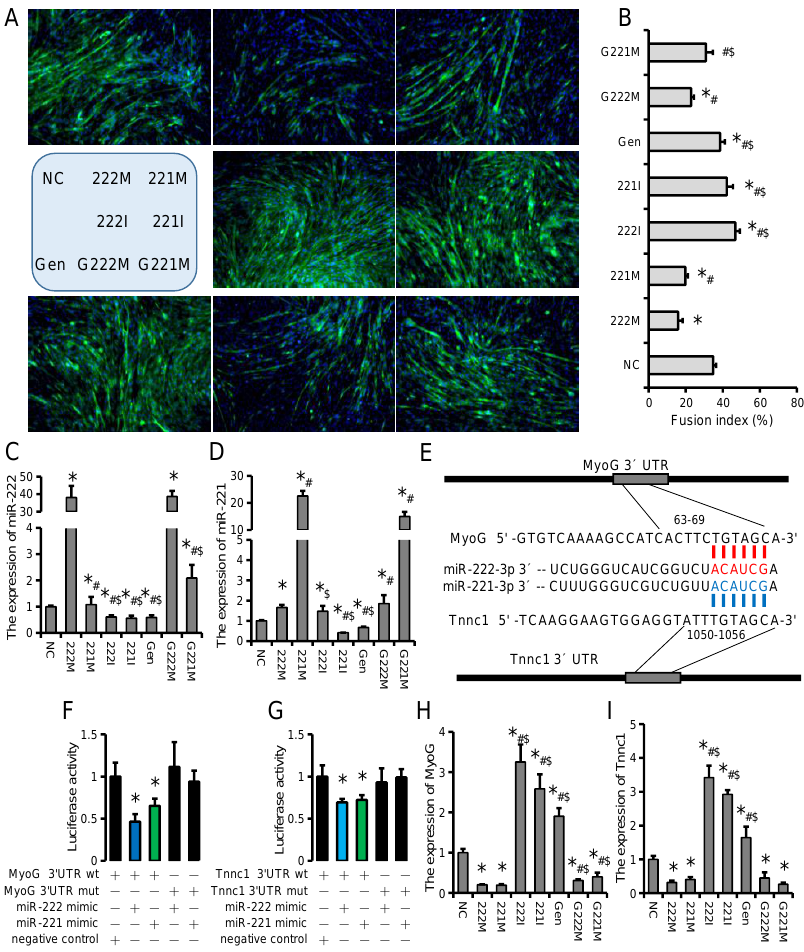
Figure 5. Effects of GEN and miR-221/222 family on C2C12 myoblast differentiation. ( A ) MyHC immunofluorescence staining of C2C12 myotubes after different treatments. ( B ) The fusion rate of C2C12 myotubes after different treatments. ( C , D ) Expression of miR-222 ( C ) and miR-221 ( D ) in C2C12 myotubes after different treatments. ( E ) The binding sites prediction of MyoG / Tnnc1 and miR-221/222 family. ( F , G ) Fluorescence intensity of the dual-luciferase reporter assay system for the potential binding sites of miR-221/222 family and MyoG ( F ) / Tnnc1 ( G ). ( H , I ) Expression of MyoG ( H ) and Tnnc1 ( I ) in C2C12 myotubes after different treatments. n = 3. * p < 0.05, compared with the NC group, # p < 0.05, compared with 222 M group, $ p < 0.05, compared with 221 M group.